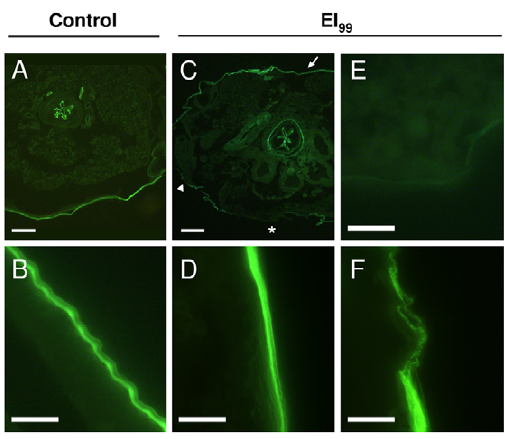
Figure 7. Novaluron alters cuticular chitin presence in late L4 larvae. WGA-FITC labeling was used to detect chitin by fluorescence microscopy. ( A , B ) Control larvae exhibiting continuous cuticle labeling. ( C–F ) Novaluron EI 99 larvae show uneven cuticle labeling. Chitin labeling of cuticle in distinct regions of the larva is rather uniform (arrow in C ; panel D ), absent (asterisk in C ; panel E ) or irregular (arrowhead in C ; panel F ). Peritrophic matrix chitin labeling was not altered ( A , C ). Bar=100 m m in A , C and 10 m m in B , D–F . All images were also recorded in bright field, in order to assure that images were in focus and that a cuticle was present (data not shown).